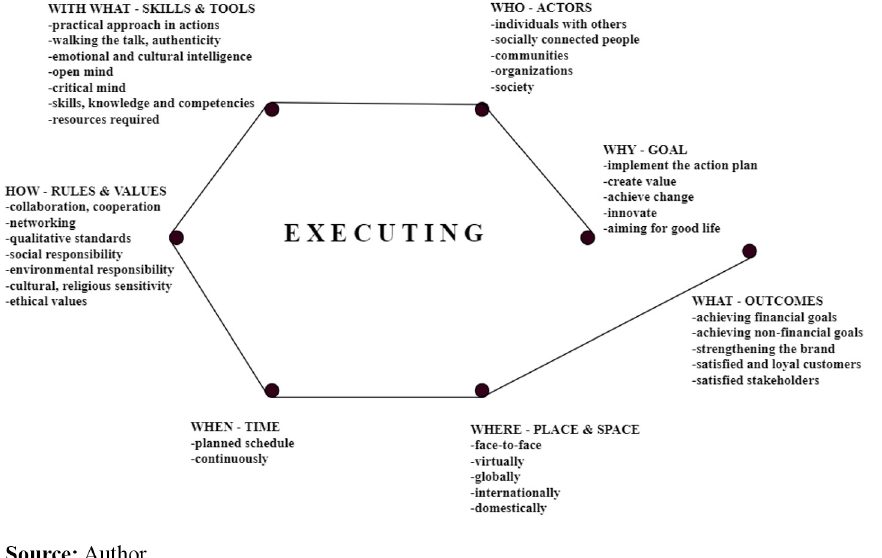
Figure 7. Executing as